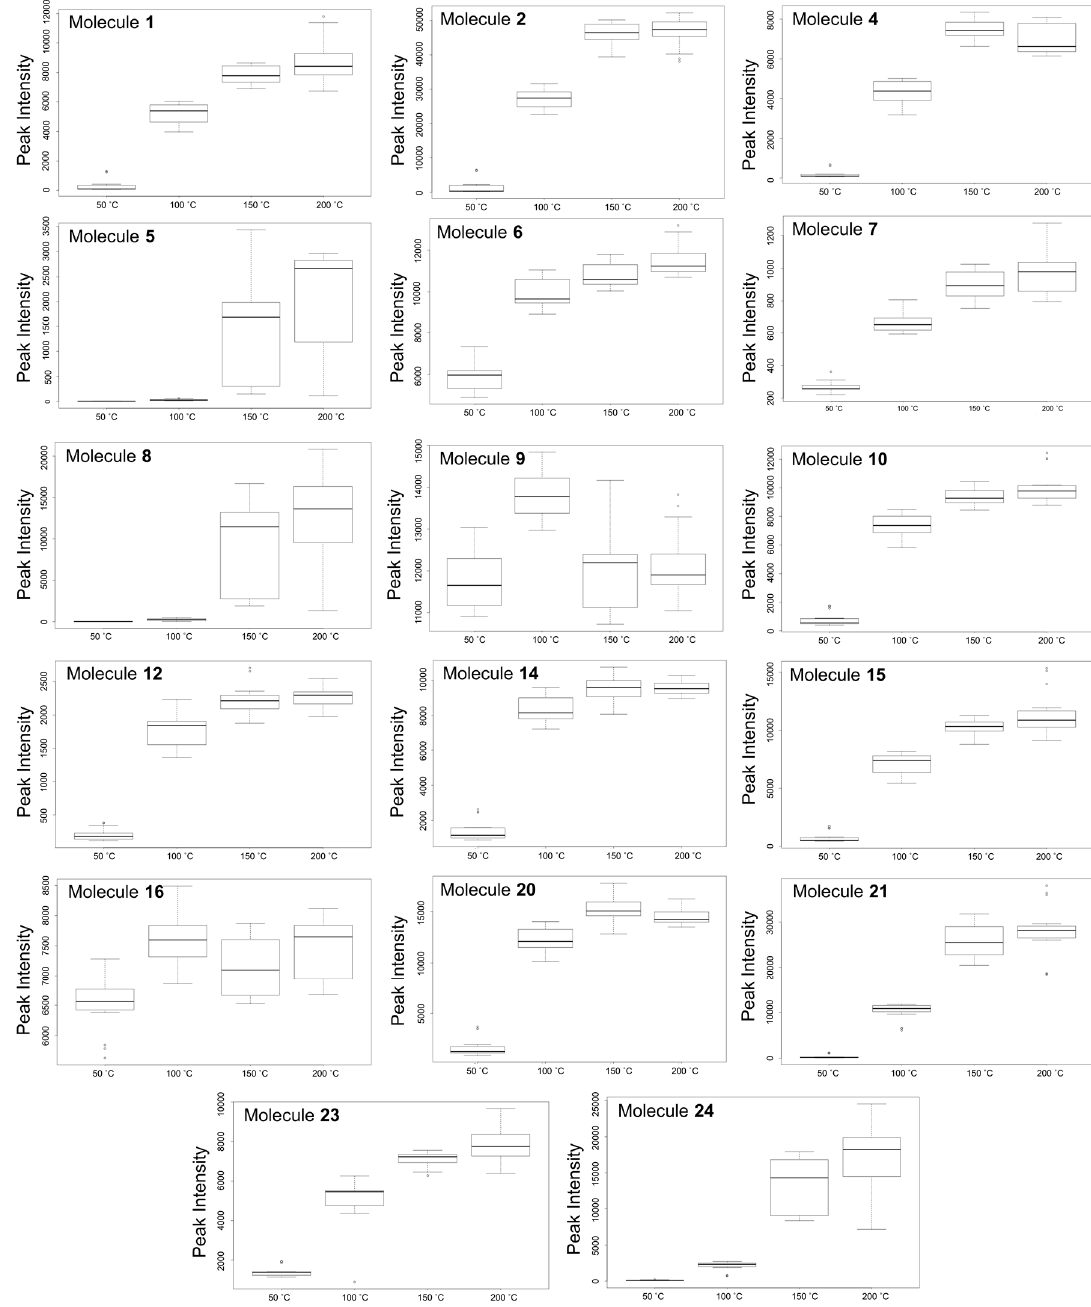
Figure 6. Box-and-whiskers plots showing the optimal temperature conditions for 17 different metabolites indicated in Table 1. All significant differences are based on ANOVA with p ≤ 0.01. Metabolites are made up of hydroxycinnamate derivatives ( 1 , 2 , 4 – 9 , 16 , 21 and 24 ) and quercetin-derived flavonoids ( 10 , 12 , 14 , 15 , 20 and 23 ) extracted from V. fastigiata during PHW extraction.